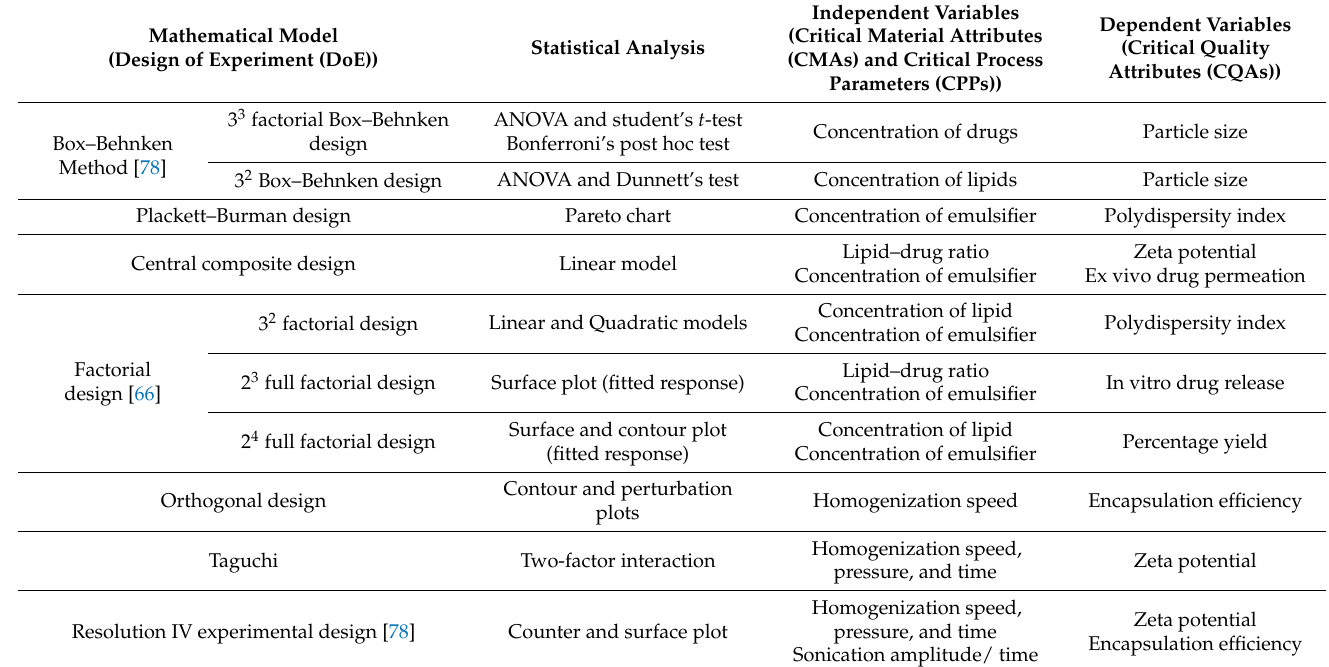
Table 3. Optimization of PLN formulation parameters using the QbD